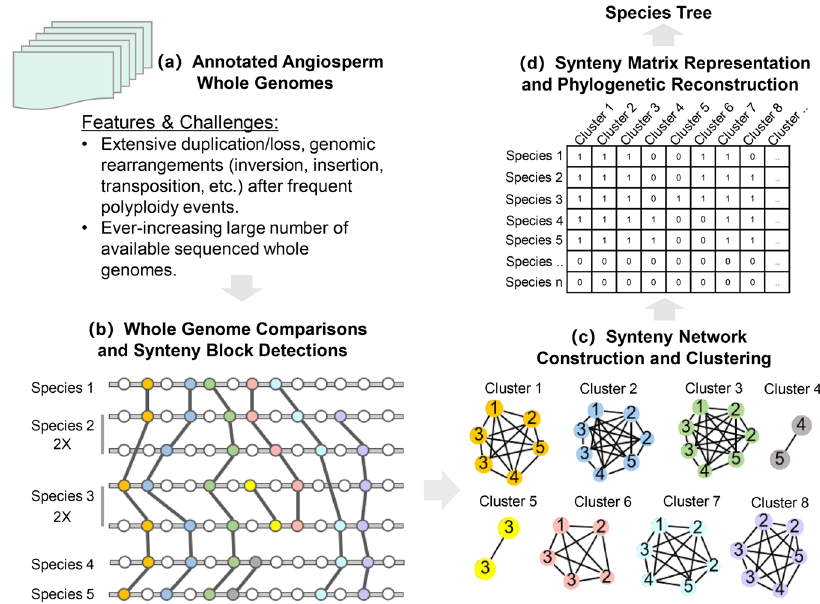
Fig. 1 Whole-genome microsynteny-based species tree inference. a Whole-genome data sets with all predicted genes are used for phylogeny reconstruction. b The synteny network approach fi rst conducts all pairwise reciprocal genome comparisons, followed by synteny block detection. Syntenic anchor pairs from all syntenic blocks constitute the synteny network database (see Methods for details). c We analyzed all synteny clusters after clustering the entire network database. Synteny clusters vary in size and node compositions. Shared genomic rearrangements are re fl ected by cluster compositions. Speci fi c anchor pairs shared by a lineage/species form speci fi c clusters (e.g. Clusters 4 – 6). We account for the presence or absence of the same recurring anchors for multiple blocks derived from whole-genome or segmental duplications (e.g. for Species 2 and 3 in Clusters 2, 3, 5, and 8). d The phylogenomic pro fi ling of all clusters constructs a binary matrix, where rows represent species and columns represent clusters. The synteny matrix comprehensively represents phylogenomic gene order dynamics. It transforms the concept of synteny comparisons from analyzing massive parallel coordinates plots into analyzing pro fi les of individual clusters/networks. Each cluster stands for a shared homologous ‘ context ’ . For example, TE activity can cause genes to be transposed as insertions into new contexts or be lost from the original context (e.g. genes in Clusters 4 – 6). As long as such transpositions are shared by different genomes (e.g. genes in Clusters 4 and 6) or within the same genome because of whole-genome duplication (e.g. genes in Cluster 5), speci fi c clusters will emerge and corresponding signals will be added to the matrix. This synteny matrix is used as the input for species tree inference by maximum likelihood (referred to as